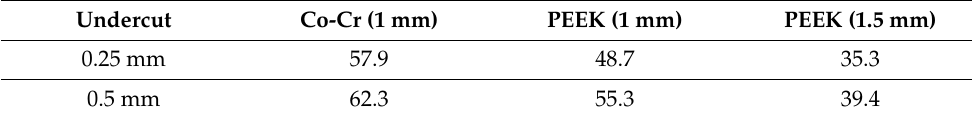
Table 4. The mean deformation of clasps ( µ m).